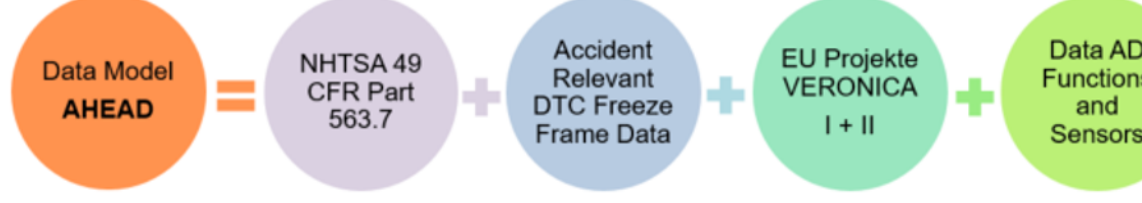
Figure 2: Structure of the AHEAD data list. Source: [20].